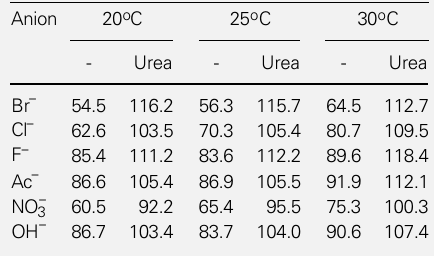
Table 1 - A 0 values (¯) for DODA monolayers in the absence and presence of 2 M urea and 1 mM NaX (X - = F - , Cl - , Br - , Ac - , NO 3- , and OH - ) at T = 20, 25, and 30 o